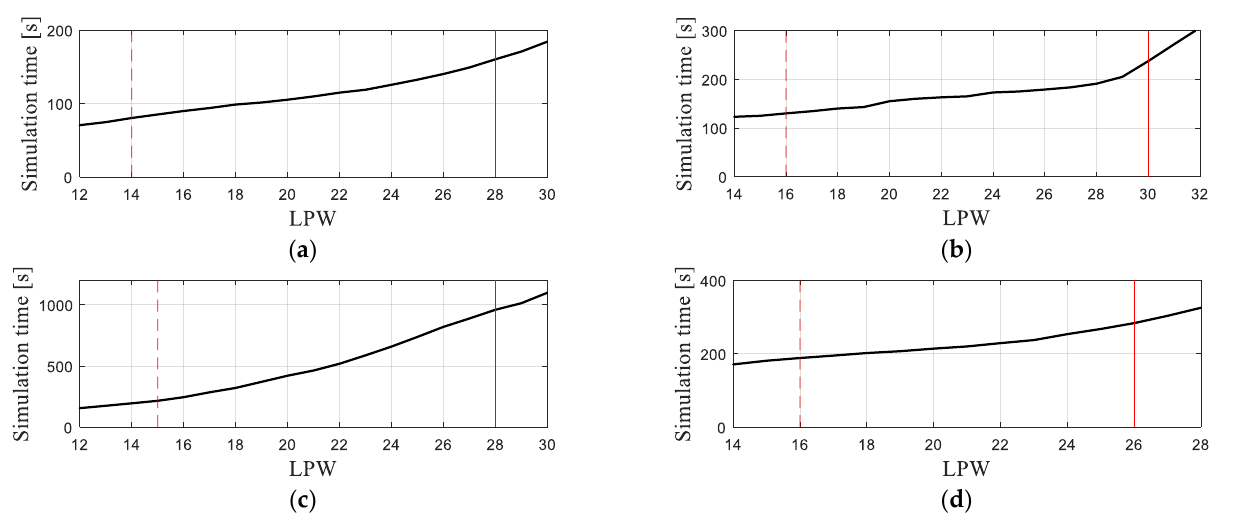
Figure 3. The dependence on the simulation time versus model resolution expressed using LPW: ( a – d ) Circuit I through IV, respectively; the low-fidelity model (- - -) and the high-fidelity model (—) are shown using vertical lines.